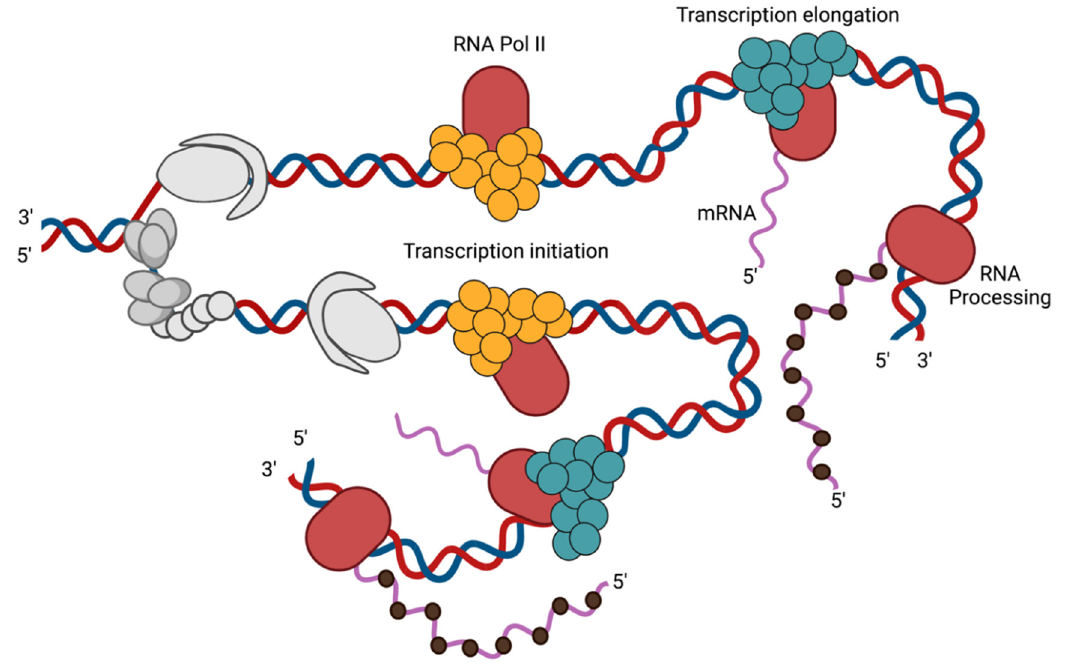
Figure 5. Representation of replication-dependent licensing of late gene transcription on HSV-1 DNA. Transcription initiation likely occurs directly after the replication fork. This is followed by transcription elongation and RNA processing. RNA pol II is shown in red, transcription initiation factors in orange, transcription elongation factors in blue, and RNA processing factors in black. Viral replication factors are in gray. RNA processing factors likely associate with the transcribing polymerase through interactions with the C -terminal tail of RNA pol II. To simplify this figure, the Okazaki fragments on the lagging strand have been removed, as well as transcription bubbles. Created with BioRender.com, accessed on 28 September 2021.